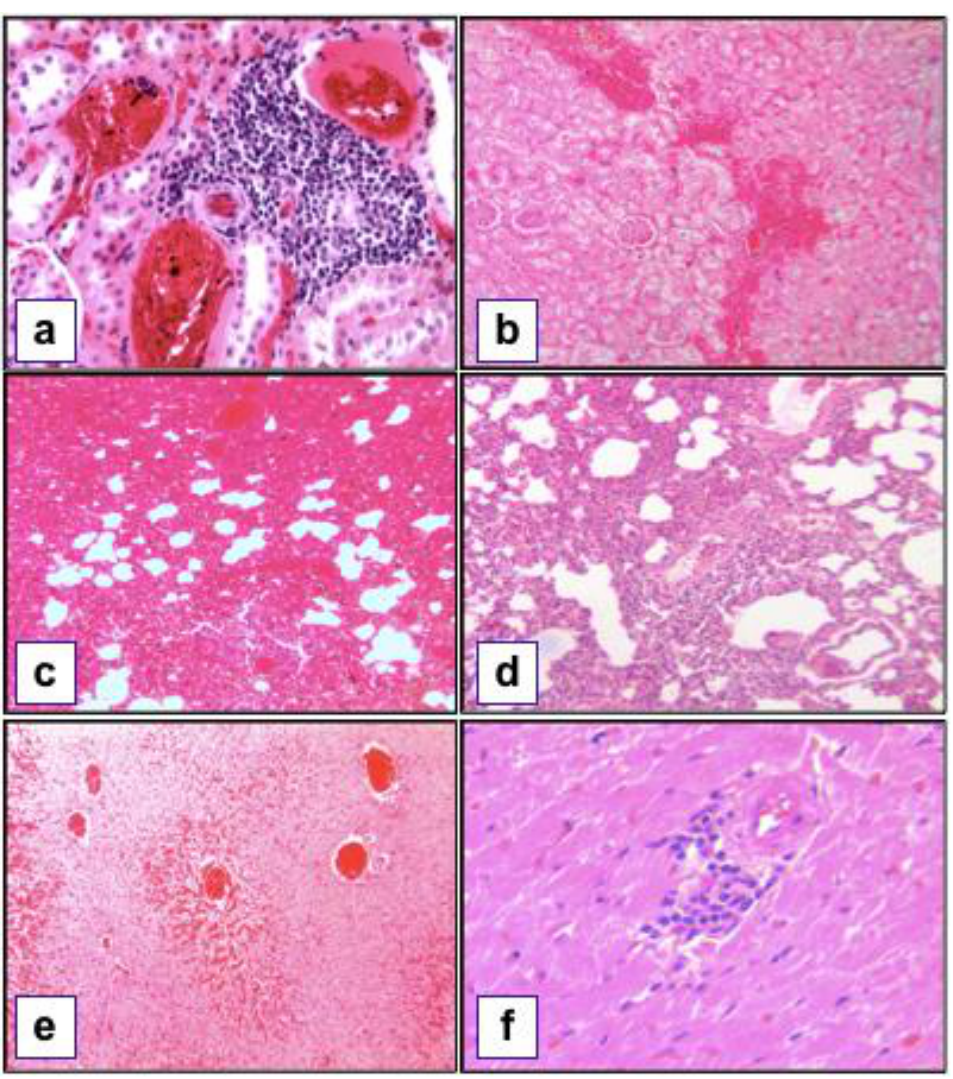
Figure 2. Histopathological findings compatible with pathogenic Leptospira spp. infection. ( a ) Lymphoplasmacytic, tubulointerstitial nephritis (H&E, 10×); ( b ) multifocal to coalescing areas of hemorrhage in the renal cortex (H&E, 10×); ( c ) diffuse hemorrhage in the lung parenchyma (H&E, 10×); ( d ) diffuse, lymphoplasmacytic alveolitis (H&E, 10×); ( e ) sinusoidal dilatation and congestion in the liver (H&E,